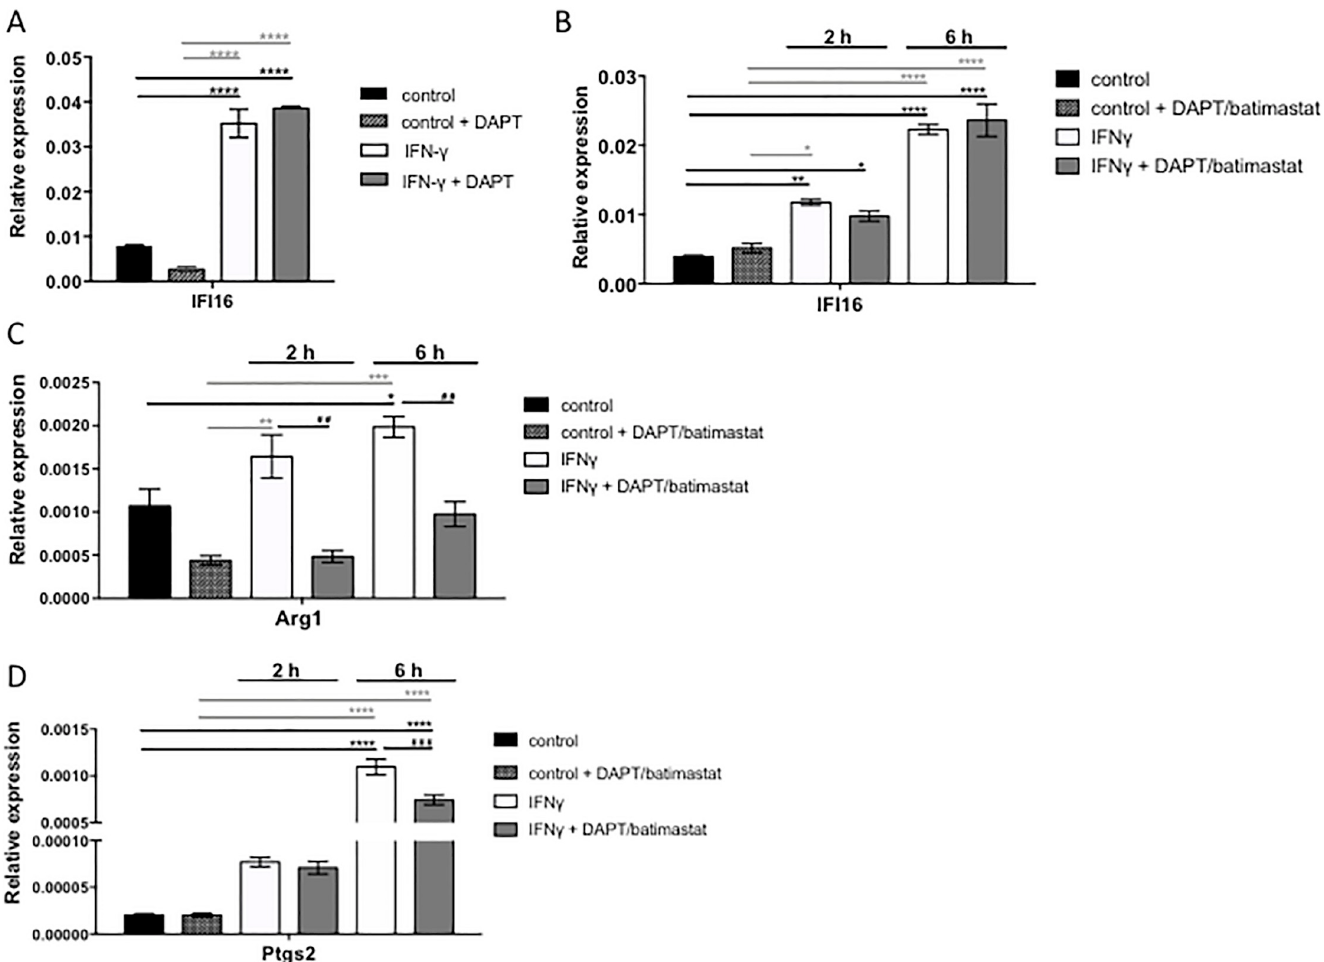
Fig 8. Influence of DAPT/batimastat on M1 macrophages. BMDMs were isolated and differentiated from cd44 +/+ control animals. For differentiation 20% L929 conditioned media was used, with a reduction of FBS on day 7 to 2%. A) On day 8 macrophages were either not stimulated (control), stimulated with DAPT (control + DAPT); 12.5 ng/ml IFN- γ only or stimulated with 12.5 ng/ml IFN- γ and 5 μ M DAPT for 6 hrs. After stimulation the cells were harvested, RNA isolation was performed and the expression of IFI16 was analysed with RT-PCR. B-D) The macrophages were stimulated on day 8 with a reduced IFN- γ concentration of 5ng/ml or together with DAPT and batimastat 5 μ M for 2 or 6 hrs. B) Shows the IFI16 expression C) the M2 macrophage gene Arg1 expression and D) the M1 macrophage gene Ptgs2 expression after stimulation under the described conditions.